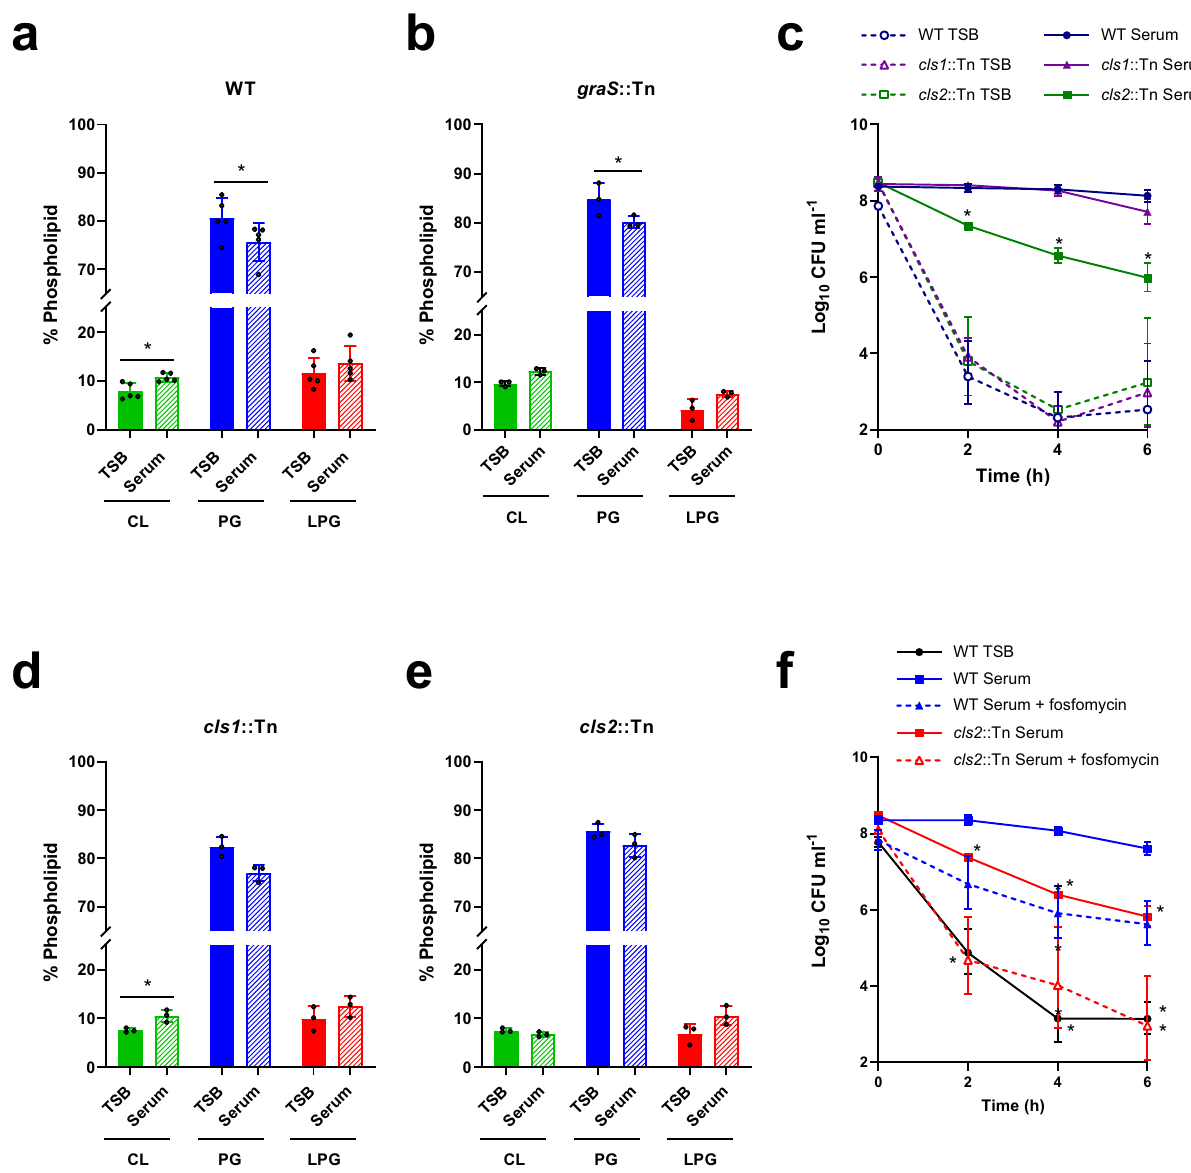
Fig. 7 GraRS-independent changes to the staphylococcal membrane also contribute to tolerance. Phospholipids were extracted from TSB-grown and serum-adapted cultures of S. aureus JE2 WT ( a ), the graS ::Tn mutant ( b ), the cls1 ::Tn mutant ( d ) and the cls2 ::Tn mutant ( e ) before being analysed by thin layer chromatography and visualised with copper sulphate and phosphoric acid. The relative phospholipid compositions were determined by quantifying spot intensities using ImageJ. Log 10 CFUml − 1 of TSB-grown and serum-adapted cultures of S. aureus JE2 WT and the cls1 ::Tn and cls2 ::Tn mutant strains during a 6 h exposure to 80 μ g ml − 1 daptomycin in serum ( c ). Log 10 CFU ml − 1 of TSB-grown and serum-adapted cultures of S. aureus JE2 WT and the cls2 ::Tn mutant strains during a 6 h exposure to 80 μ g ml − 1 daptomycin in serum ( f ). Where appropriate, adaptation was carried out with sub-lethal concentrations of fosfomycin (dashed lines). Data in ( a ), ( b ), ( d ) and ( e ) represent the mean ± standard deviation of at least three independent experiments and were analysed by paired t- tests (* for ( a ), P = 0.0015 (CL), 0.0116 (PG), 0.1002 (LPG). For ( b ) P = 0.2642 (CL), 0.0222 (PG), 0.1069 (LPG). For ( d ), P = 0.0491 (CL); TSB-grown vs serum-adapted for each phospholipid). Data in ( c ) and ( f ) represent the geometric mean ± geometric standard deviation of three independent replicates and were analysed by two-way ANOVA with Dunnetts ’ s post-hoc test * for ( c ), P = 0.0008 (2 h), 0.001 (4 h) and 0.0066 (6 h) serum-adapted WT vs serum-adapted mutant. For ( f ), P = 0.0163 (2 h WT TSB), 0.0115 (4 h WT TSB), 0.0018 (6 h WT TSB), 0.0022 ( cls 2::Tn Serum 2 h), 0.0002 ( cls 2::Tn Serum 4 h), 0.0034 ( cls 2::Tn Serum 6 h), 0.0349 ( cls 2::Tn Serum + fosfomycin 6 h). CL, cardiolipin;